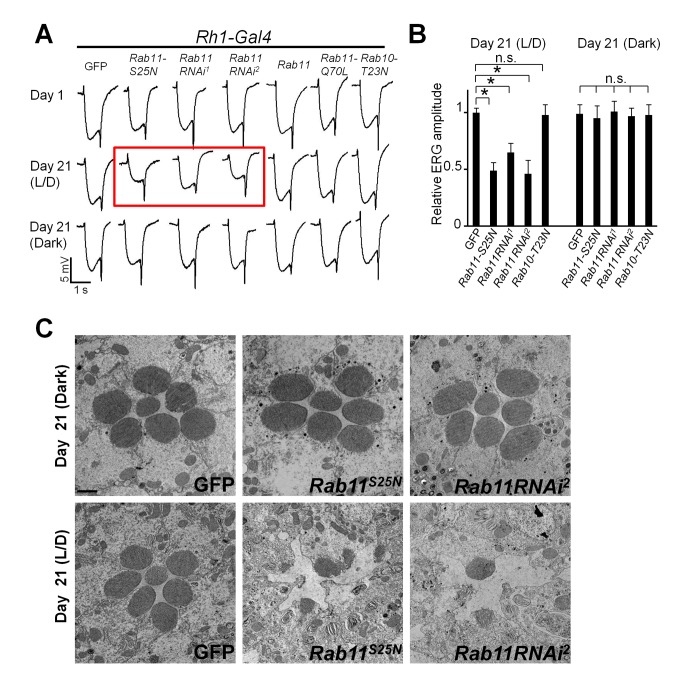
Knockdown of Rab11 in adult eye causes light-dependent photoreceptor degeneration.(A) ERG traces of flies with expression of UAS-GFP, Rab11-DN(S25N), Rab11 double-stranded RNA constructs (Rab11 RNAi1 and Rab11 RNAi2), Rab11, Rab11-CA(Q70L), and Rab10-DN(T23N) driven by Rh1-GAL4 at day 1 and day 21 with or without 12-h on/off light exposure (L/D). Note that the ERG amplitudes are reduced in the flies with Rab11 knockdown and light exposure (red box). (B) Quantification of ERG depolarization amplitudes shown in (A). Five ERG traces were measured for each genotype at each time point. An asterisk indicates a p-value less than 0.05; “n.s.” indicates a p-value greater than 0.05. (C) TEM of photoreceptor cross-sections of flies expressing GFP, Rab11-DN, or Rab11 RNAi2 in photoreceptor cells after 21 d of incubation in light/dark cycle or in constant dark. Note that the rhabdomere morphology is disrupted in flies with Rab11 knockdown upon light exposure. Since Rh1-GAL4 drives expression only in R1–R6 photoreceptors, R7/R8 are better preserved than R1–R6. Scale bar, 1 µM.